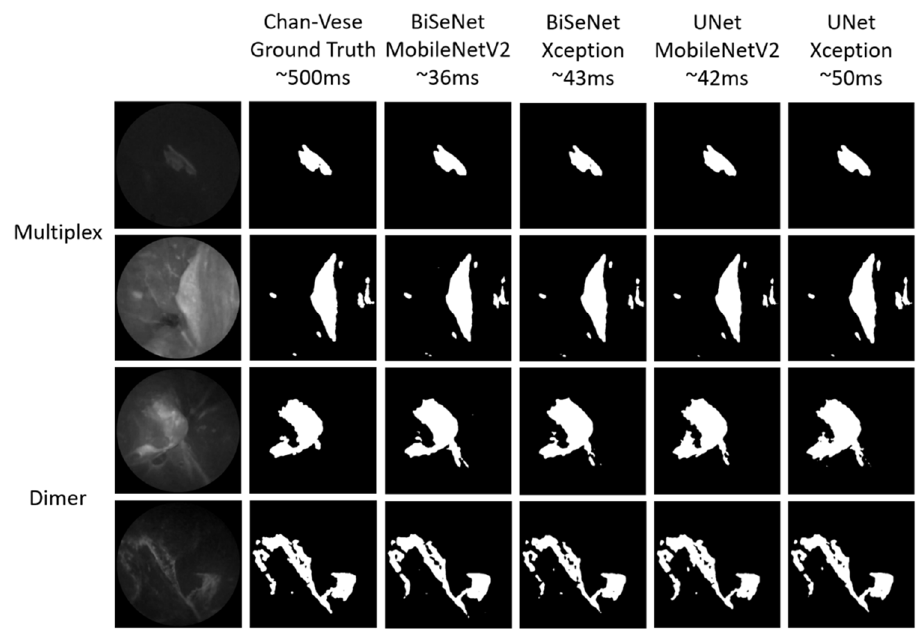
Figure 7. Representatives of segmentation results for BiSeNet and UNet models with MobileNetV2 and Xception backbones.